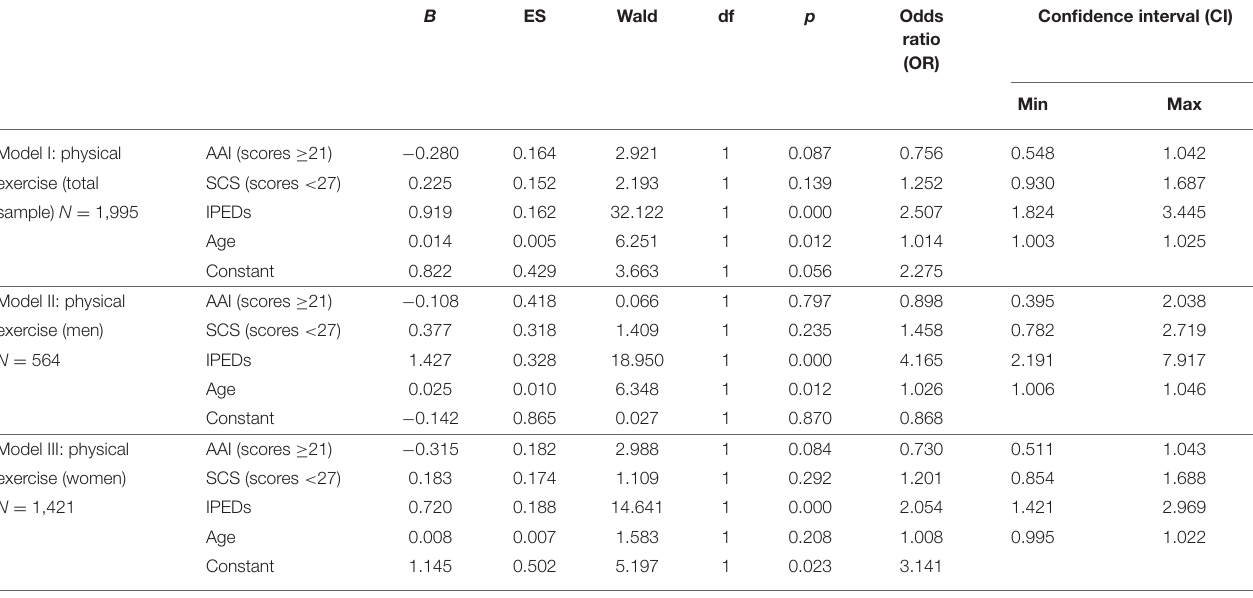
TABLE 6 | Physical exercise logistic regression model (total and by gender).